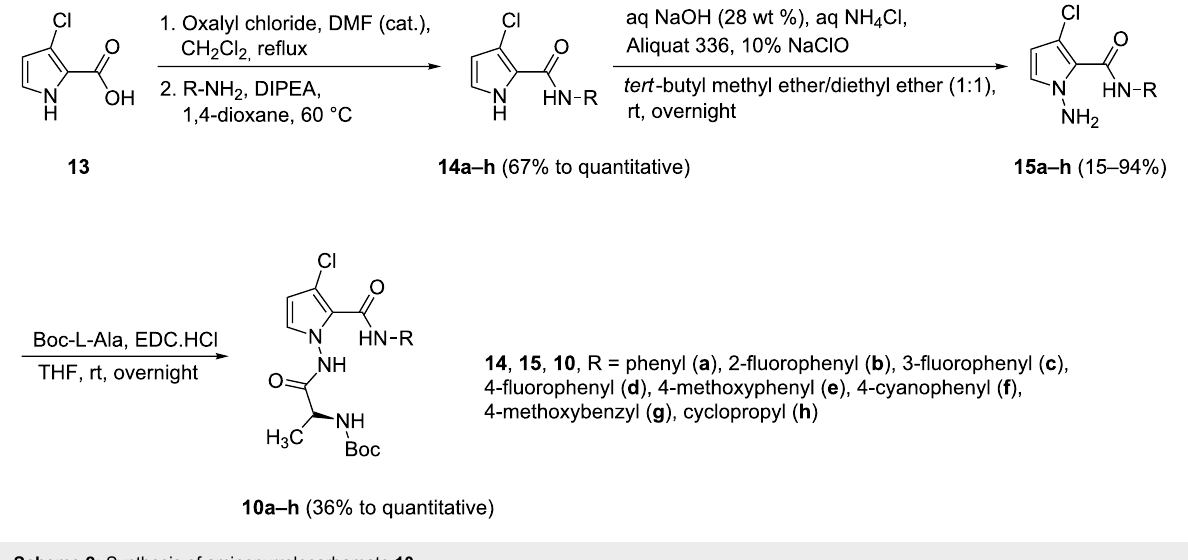
Scheme 2: Synthesis of aminopyrrolocarbamate 10